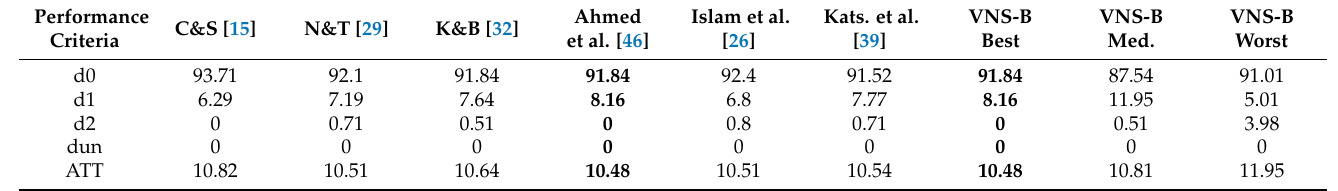
Table 1. Comparison of the final solution generated between methods for 4-Route